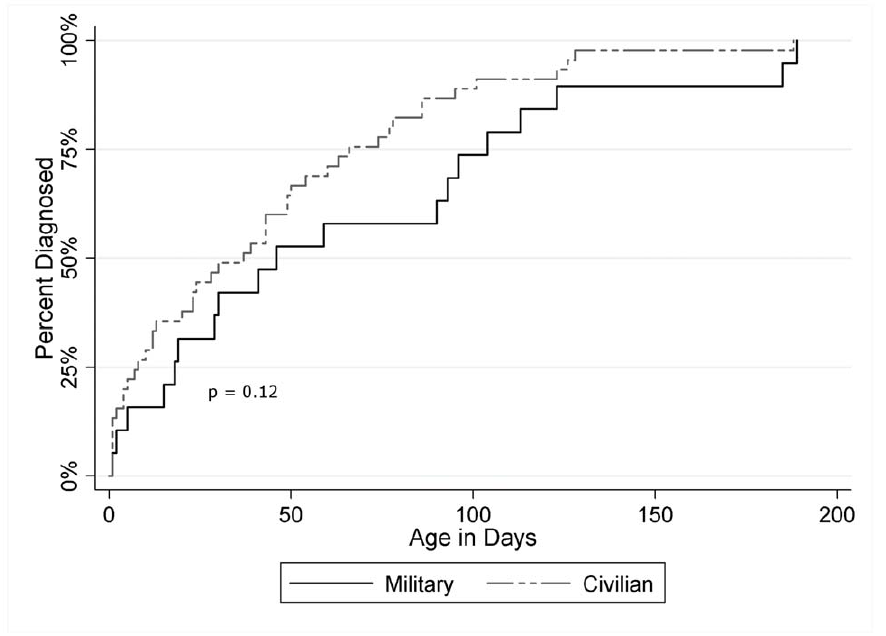
Figure 3. Cumulative prevalence of documented biliary atresia within the Military Health System by primary care model.